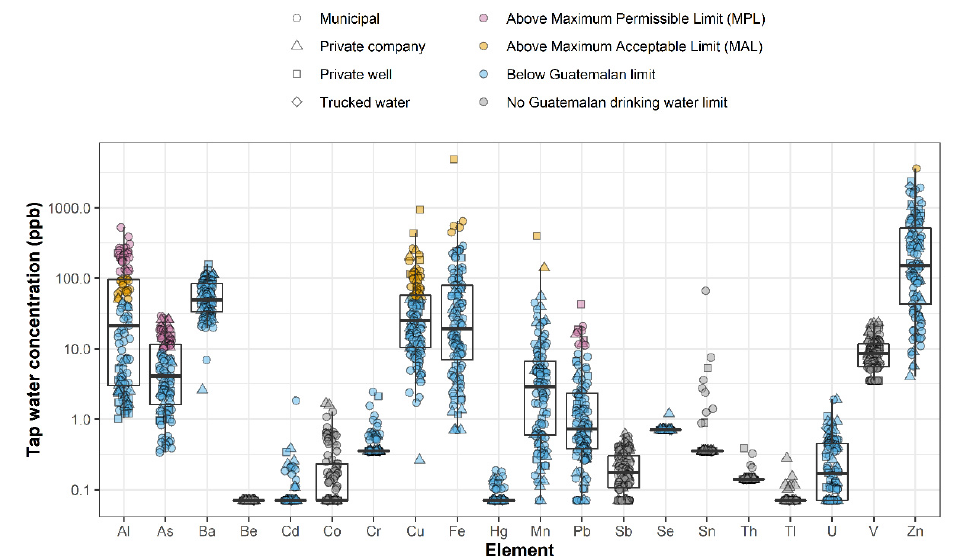
Figure 3. Distribution of metals concentrations in first draw tap water samples among all water providers sampled in the Guatemala City metropolitan area. Horizontal lines of each box indicate the first quartile, median, and third quartile for each metal. Vertical black lines indicate the spread of the data up to ± 1.5 times the interquartile range. Symbol colors separate samples by established limits while shapes sort the samples by provider